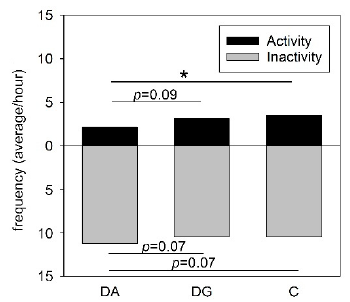
Figure 2. Activity and inactivity of the three treatment groups of DA (deprivation alone), DG (deprivation with a group of littermates) and C (control, no deprivation) 1 h after LPS application. Significant differences are indicated by asterisks (* p < 0.05; n = 20 pigs per treatment group).